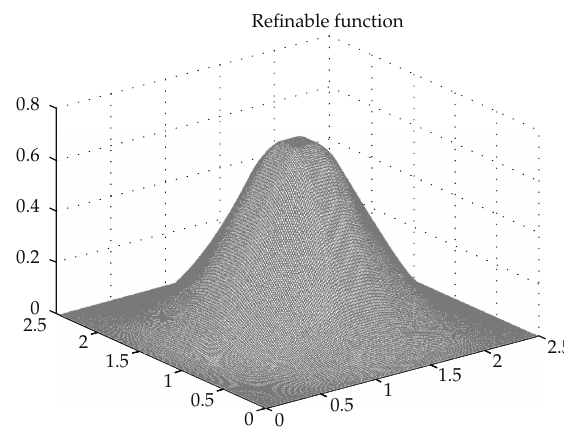
Figure 2: The symmetric refinable componentwise polynomial function f